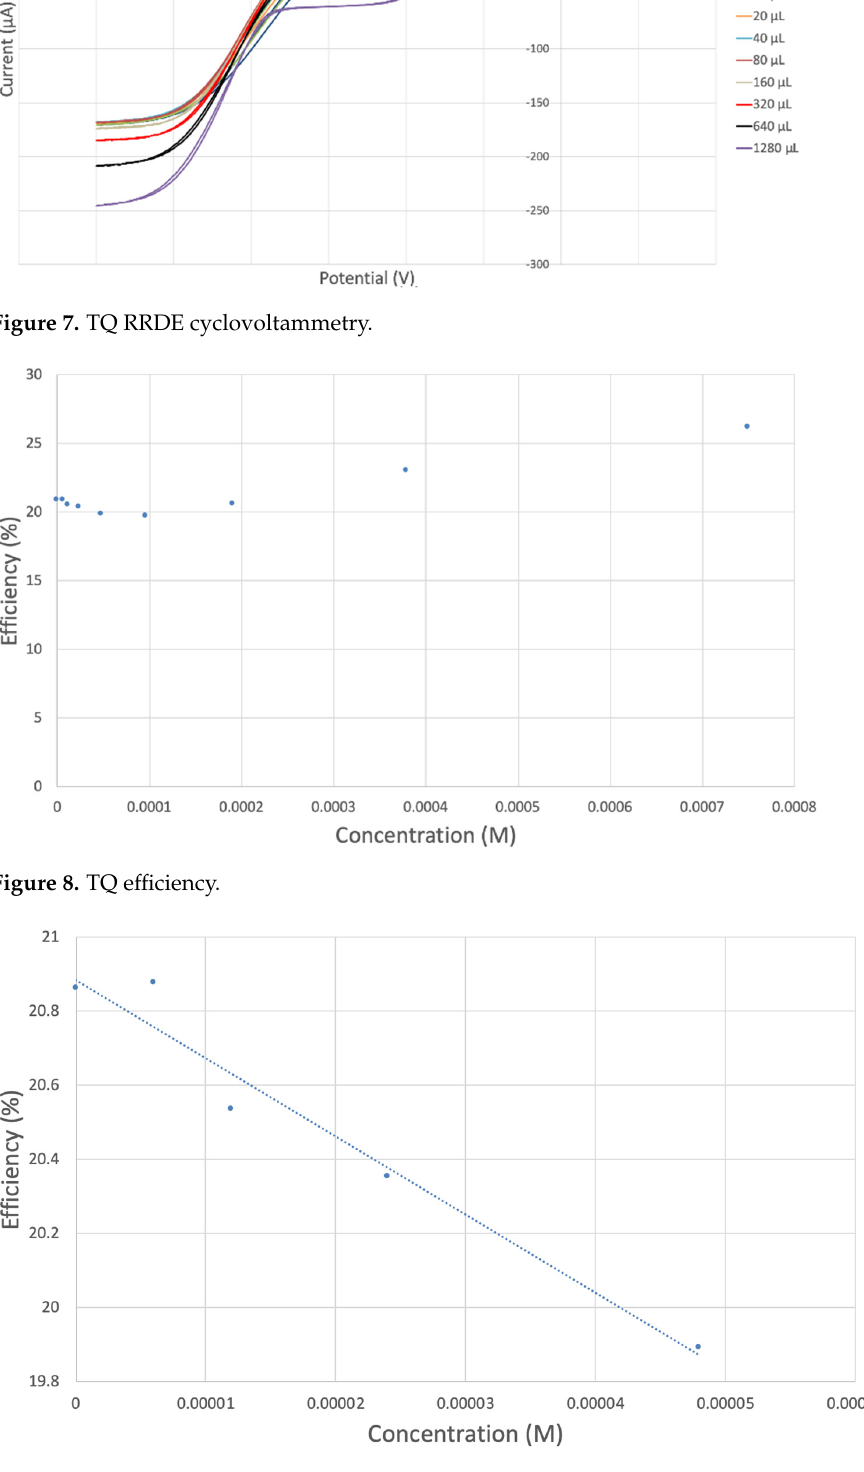
Figure 9. TQ collection efficiency for blank plus first four aliquots, whose line equation is y = − 21104x + 20.9 (R 2 = 0.9965).